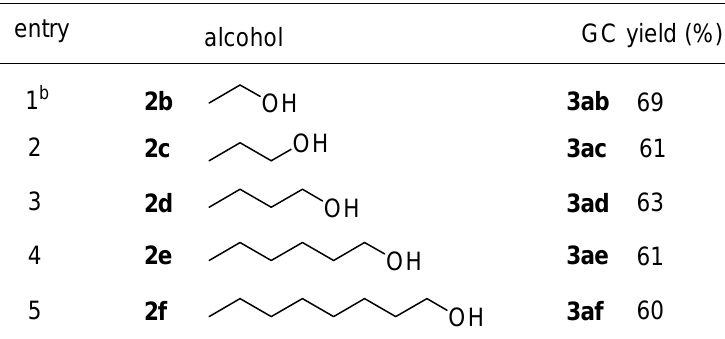
Table 2. ZrOCl ·8H O-catalyzed esterification of acrylic acid ( 1a ) with aliphatic alcohols a 2 2